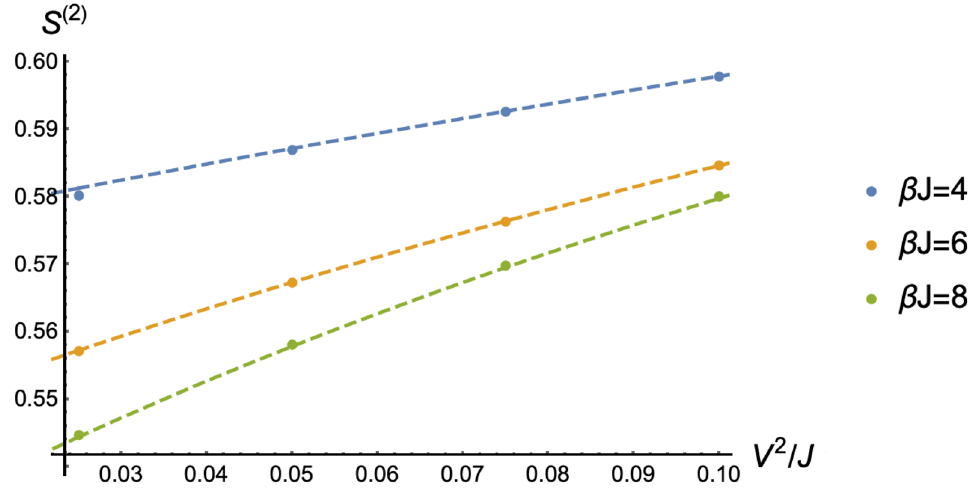
Figure 7. We compare the value of S (2) (cid:31) R(cid:19)enyi entropy S (2) between (cid:31) and in the thermal density matrix of a single system (the dashed th